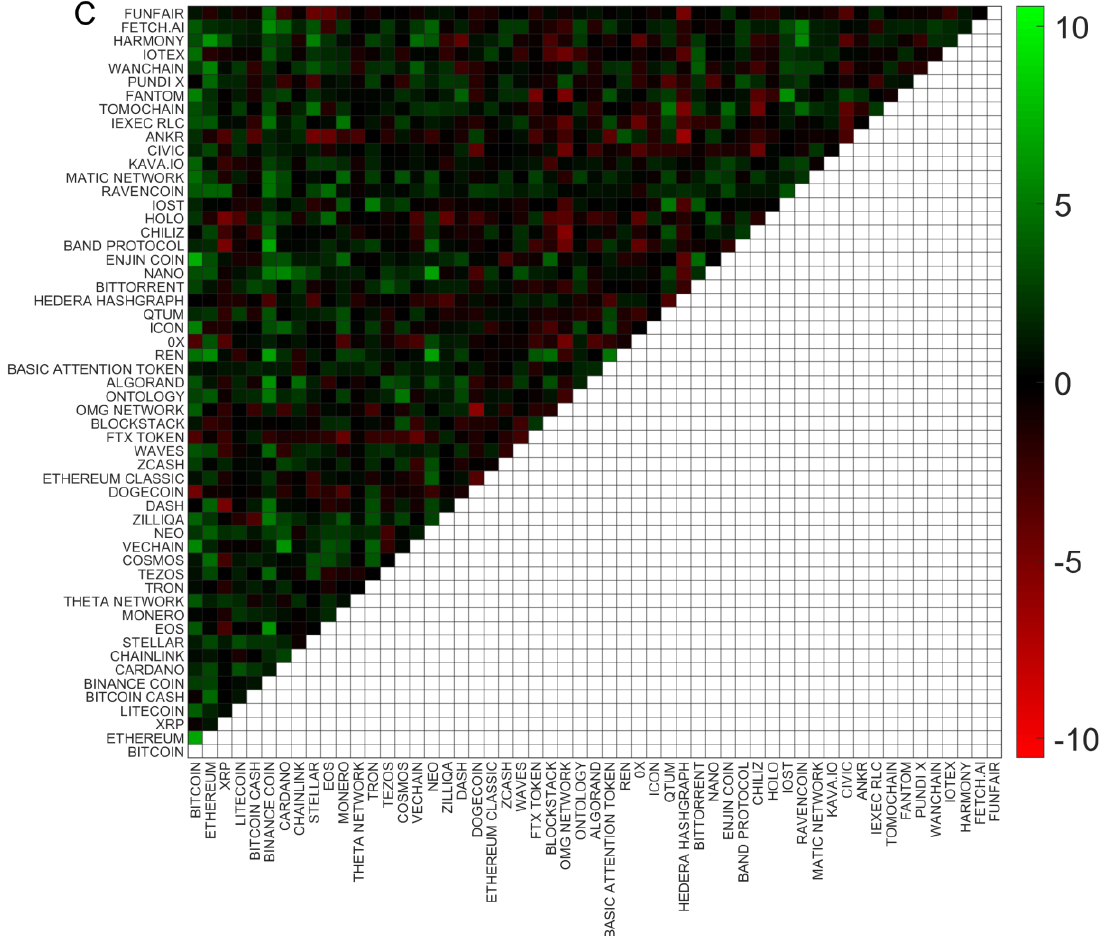
Fig. 7C. Asynchronous trading condition with higher frequency of trading for the smaller market capital cryptocurrency. Pixel values mean the same as in 7A, except that the larger market capital cryptocurrency in the corresponding pair is traded at a higher